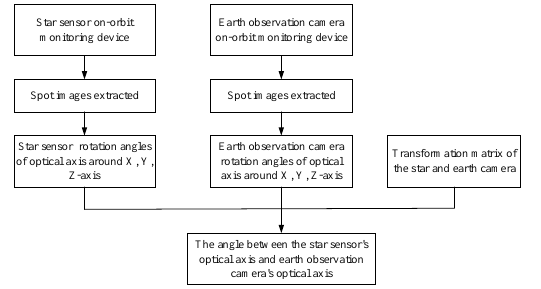
Figure 8. Data processing flow of the angle between the